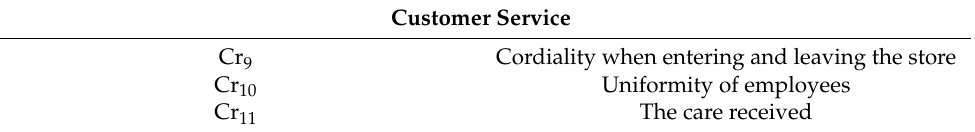
Table 5. External